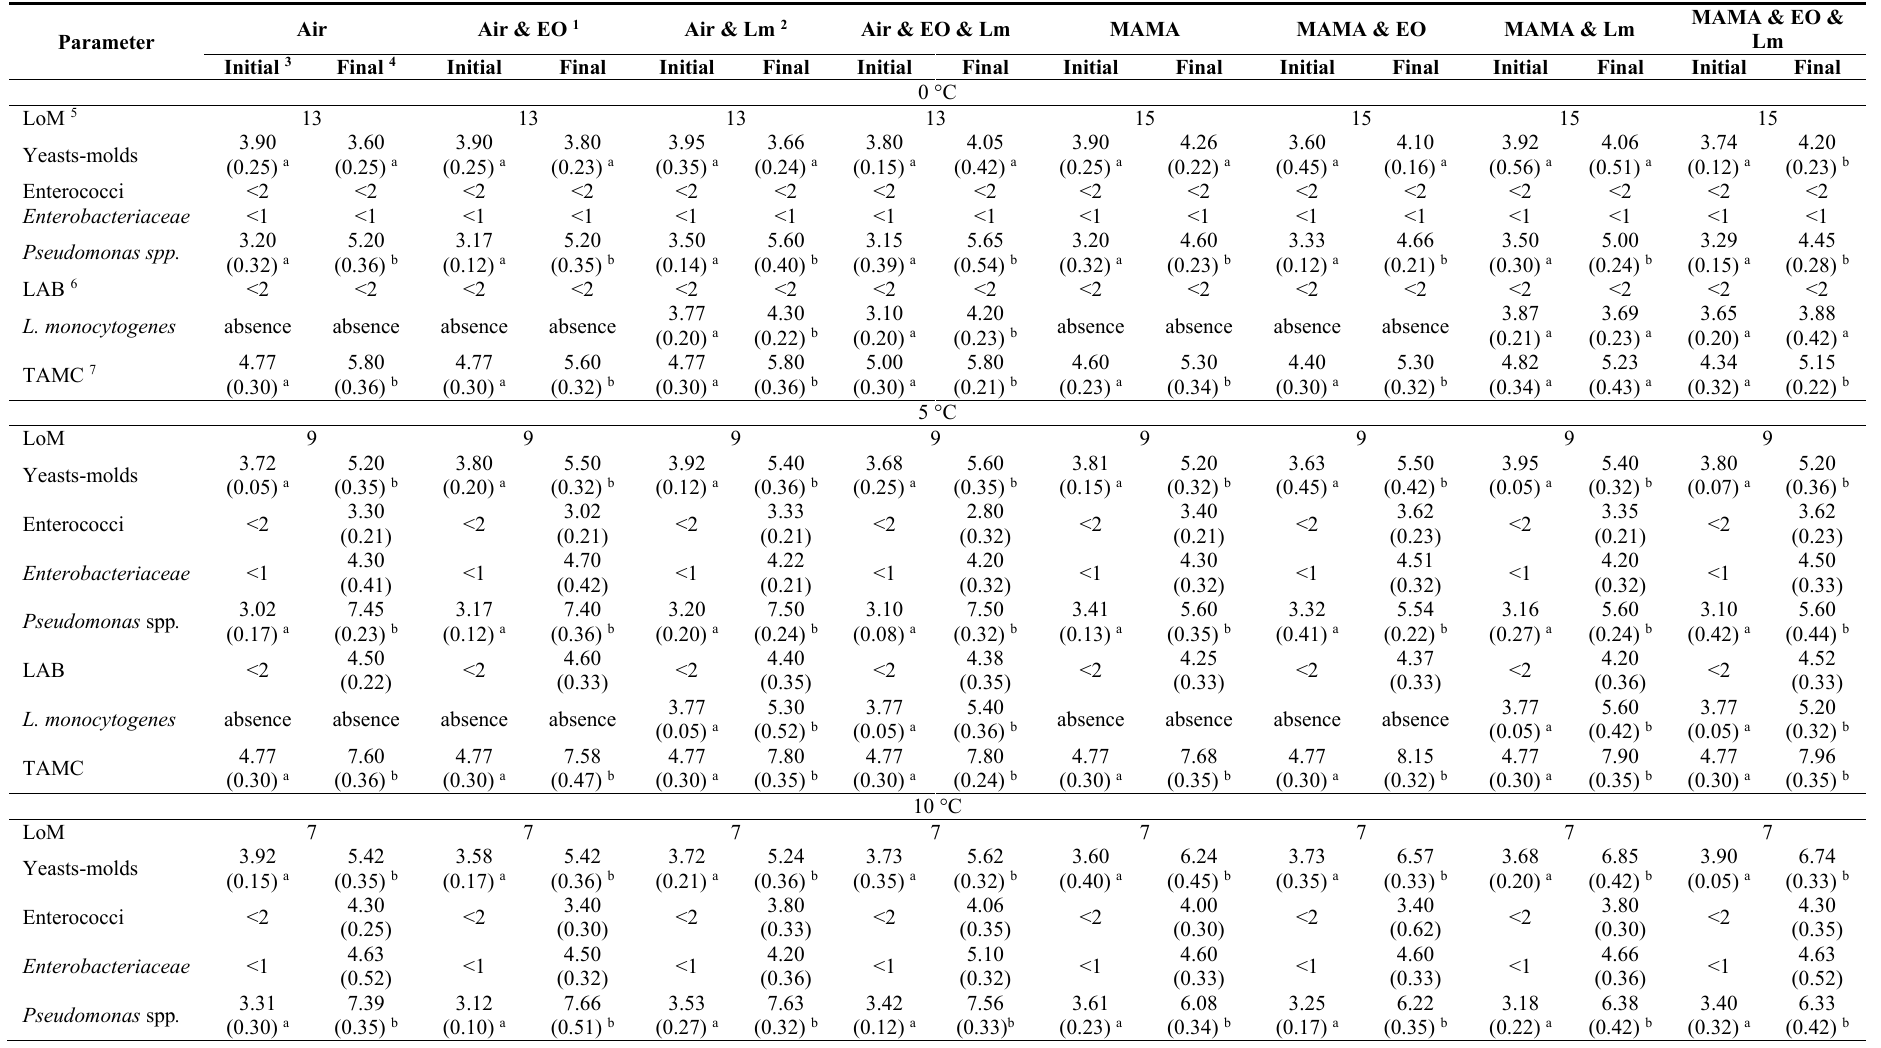
Table 2. Limit of marketability (days) and microbial population dynamics (log CFU·g −1 ) during incubation of melon at 0, 5, 10, and 15 °C packaged in air or MAMA conditions, with or without lemongrass essential oil, with or without inoculation with L. monocytogenes .